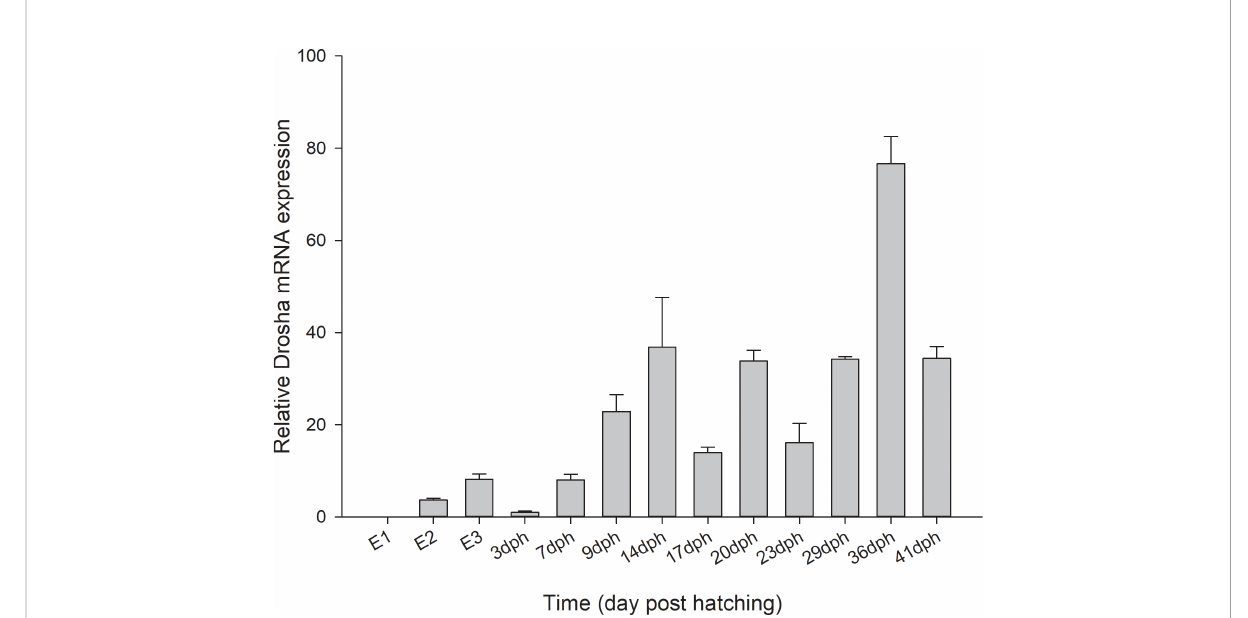
FIGURE 4 Relative levels of Drosha mRNA during early development of Japanese fl ounder. Expression values were normalized to those of b -actin, and data are expressed as the mean ± Standard Error (SE) (n = 3) from the calibrator group (E1). E1, unfertilized stage; E2, gastrula stage; E3, heart- beating stage.